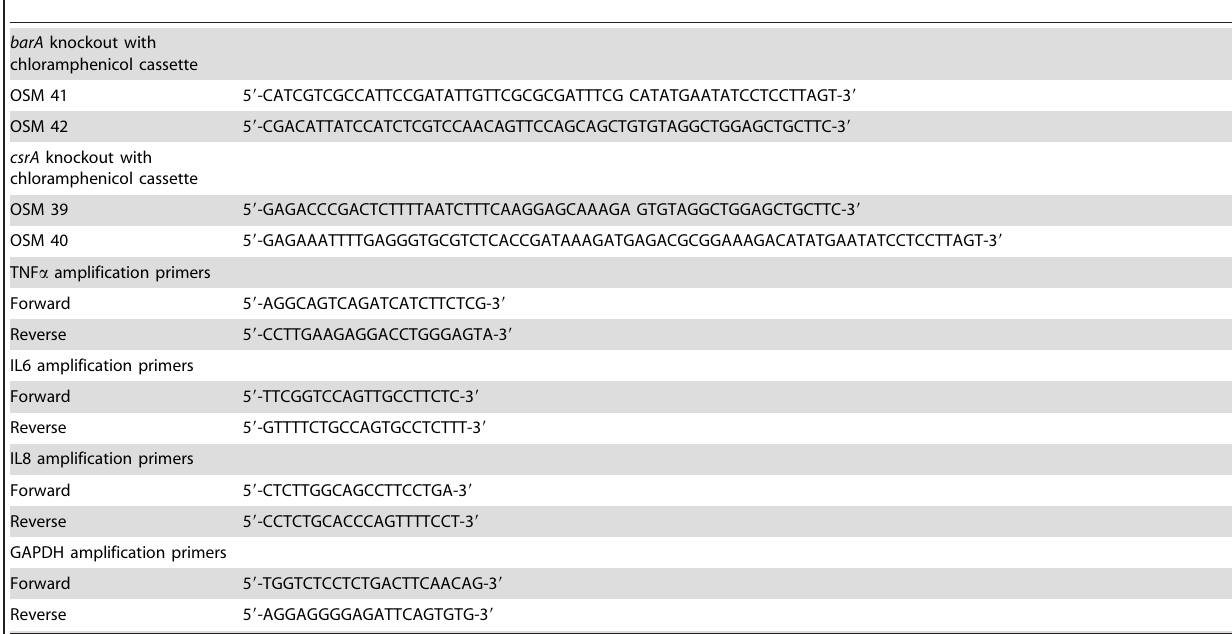
Table 1. Primers used in this study.